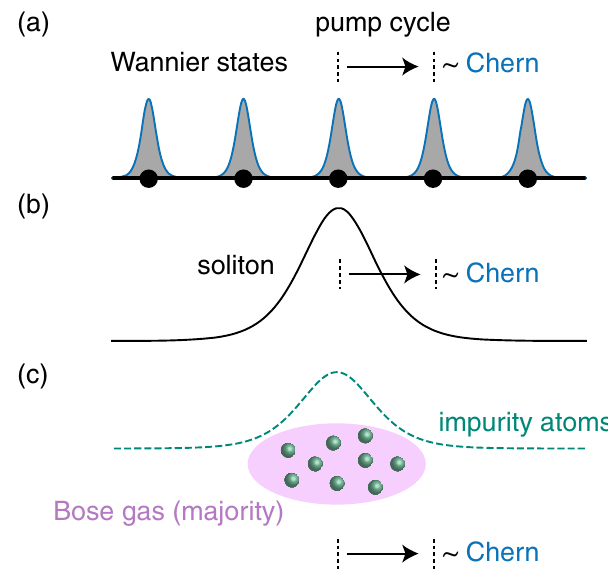
Fig. 1 | Schematics of the soliton pumping mechanism and nonlinearity- induced pumping in ultracold mixtures. a In a Thouless pump, the Wannier functions perform a quantized drift established by the Chern number of the cor- responding band. b In a nonlinear setting, the motion of a soliton follows the quantized Wannier drift. c In a Bose-Bose atomic mixture, quantized pumping can be induced by interactions: a soliton of impurity atoms is dragged by the driven majority atoms, leading to interaction-induced topological